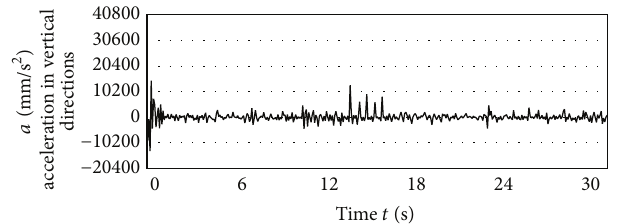
Figure 10: Acceleration curve of the bodywork centroid in vertical direction.